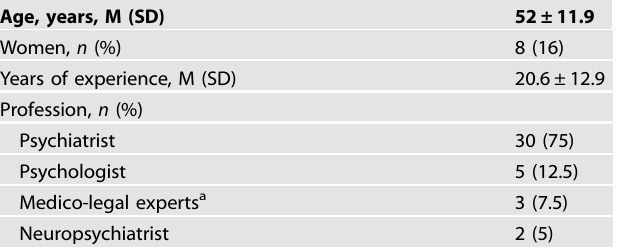
Table 3. Forensic experts ’ sample characteristics.